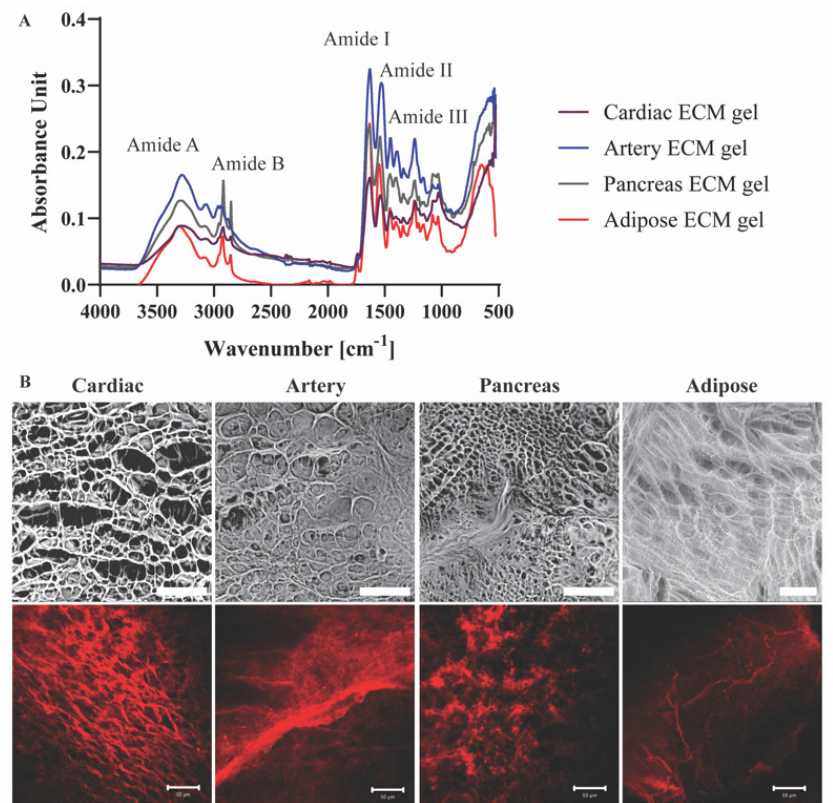
Figure 3. pECM hydrogels structural characterization. ( A ) FTIR spectra of pECM hydrogels. ( B ) Upper panel: SEM images of pECM hydrogels. Scale bar, 100 μ m. Bottom panel: Immunostaining Upper panel: SEM images of pECM hydrogels. Scale bar, 100 µ m. Bottom panel: Immunostaining of of collagen I. Scale bars, 50 μ m. collagen I. Scale bars, 50 µ